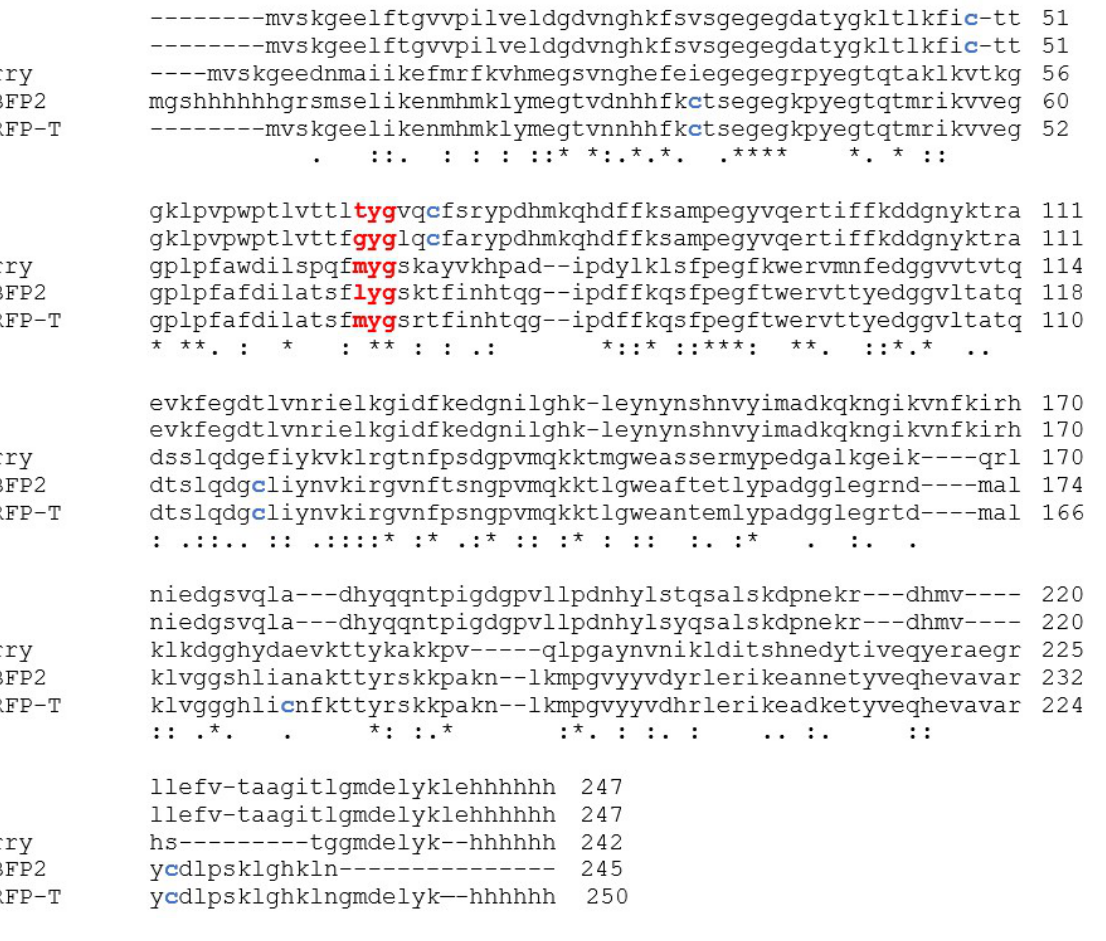
Figure 7. Sequence alignment for the proteins studied in this work. Proteins have been aligned using Clustal 2.1 multiple alignment tool. Stars (*) indicate identities and dots indicate a higher (:) and a lower (.) degree of similarity. Cys residues are highlighted in blue. Residues in red are involved in chromophore formation and were used for sequence alignments (note the hexa-histidine tag used